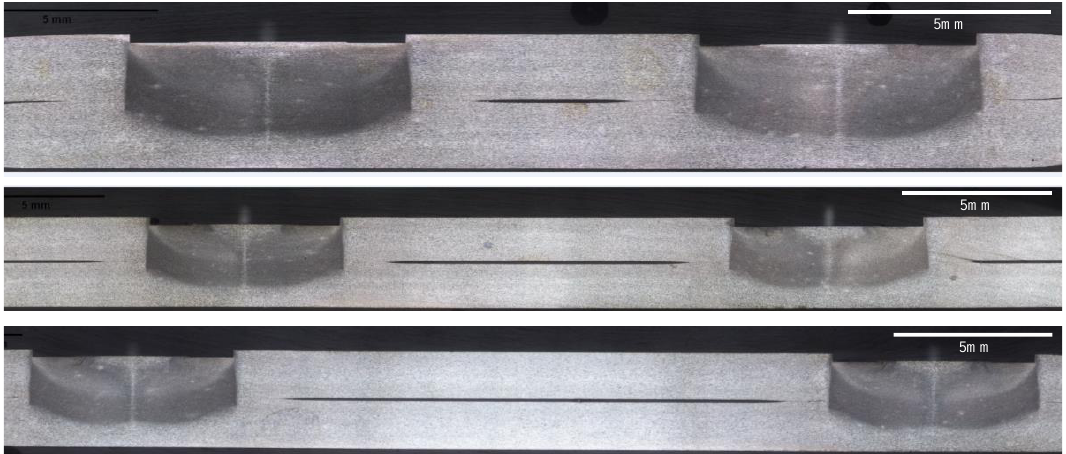
Figure 15. Two-spot cross-section specimens: (top) 2D-pitch; (middle) 3D-pitch; (bottom) 4D-pitch. Notes: D = 7 mm (Spot Weld Diameter); pitch = Spot Weld Spacing.